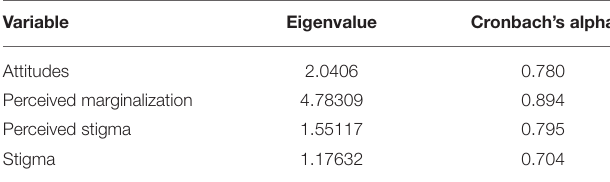
TABLE 1 | Factor analysis results for scale